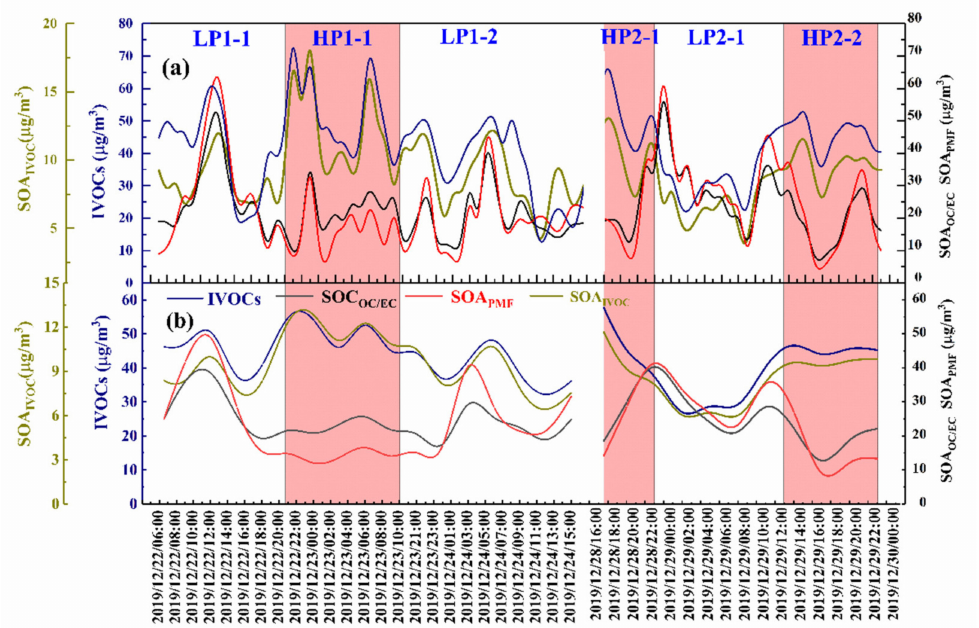
Figure 6. Time series of different SOA productions during haze episodes with ( a ) hourly resolution and ( b ) 3 h